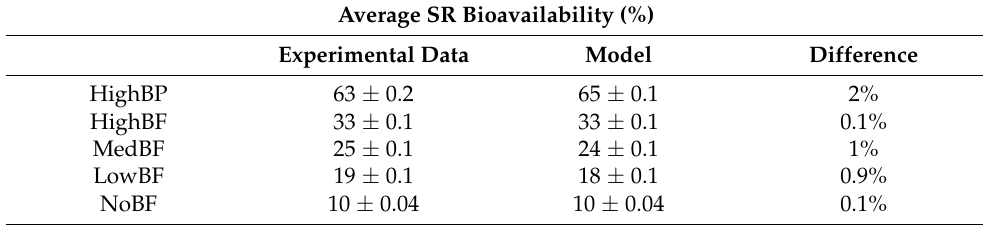
Table 3. Average sulforaphane (SR) bioavailability values ± SD for the experimental data and model. There were minor differences between the experimental bioavailability and model bioavailability for each broccoli product type.